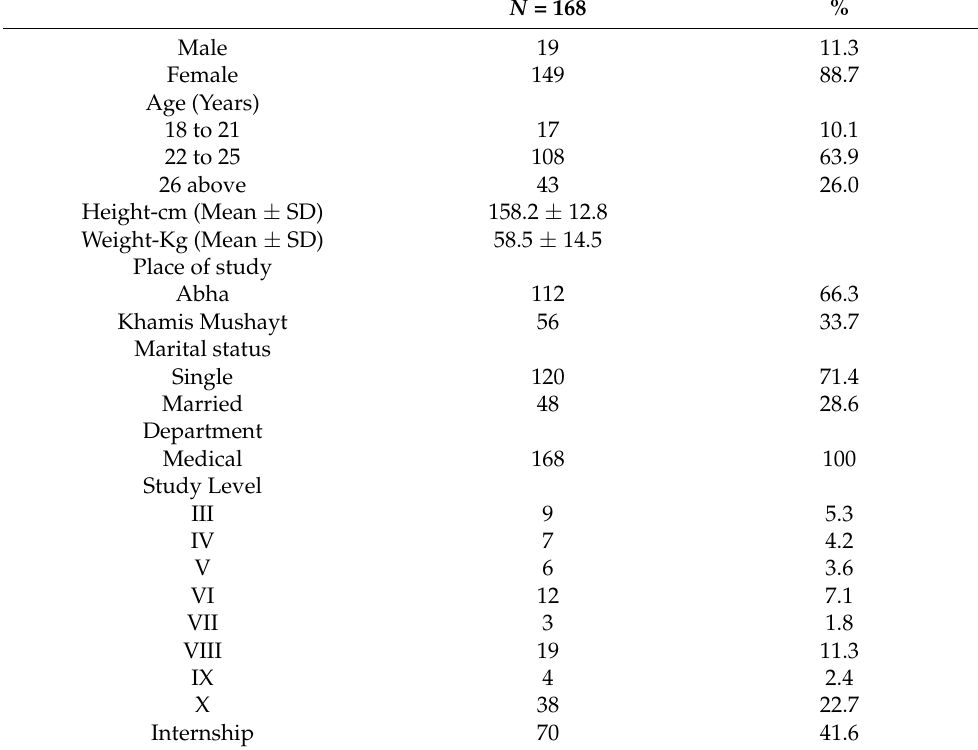
Table 1. Demographic characteristics and distribution of the participants.